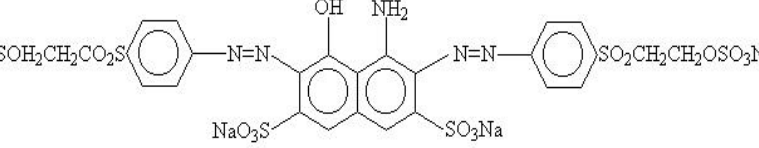
Figure 1. Example of an azo dye